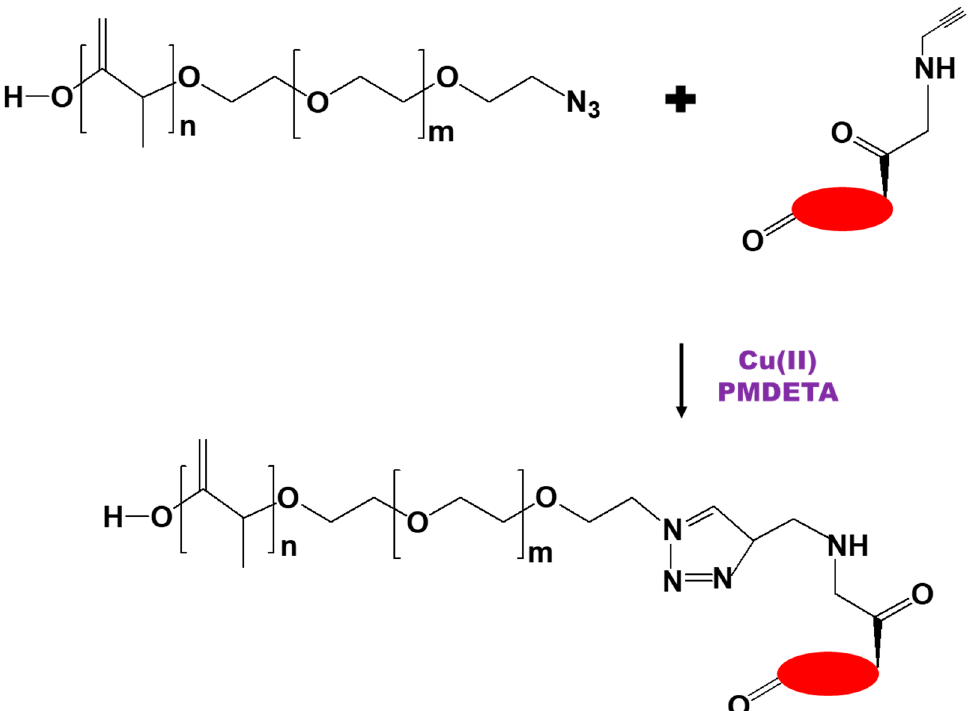
Figure 8. Scheme for the synthesis of a dexamethasone conjugate with N 3 -polyethylene glycol- polylactic acid copolymer by Cu(II)-catalyzed cycloaddition [87].